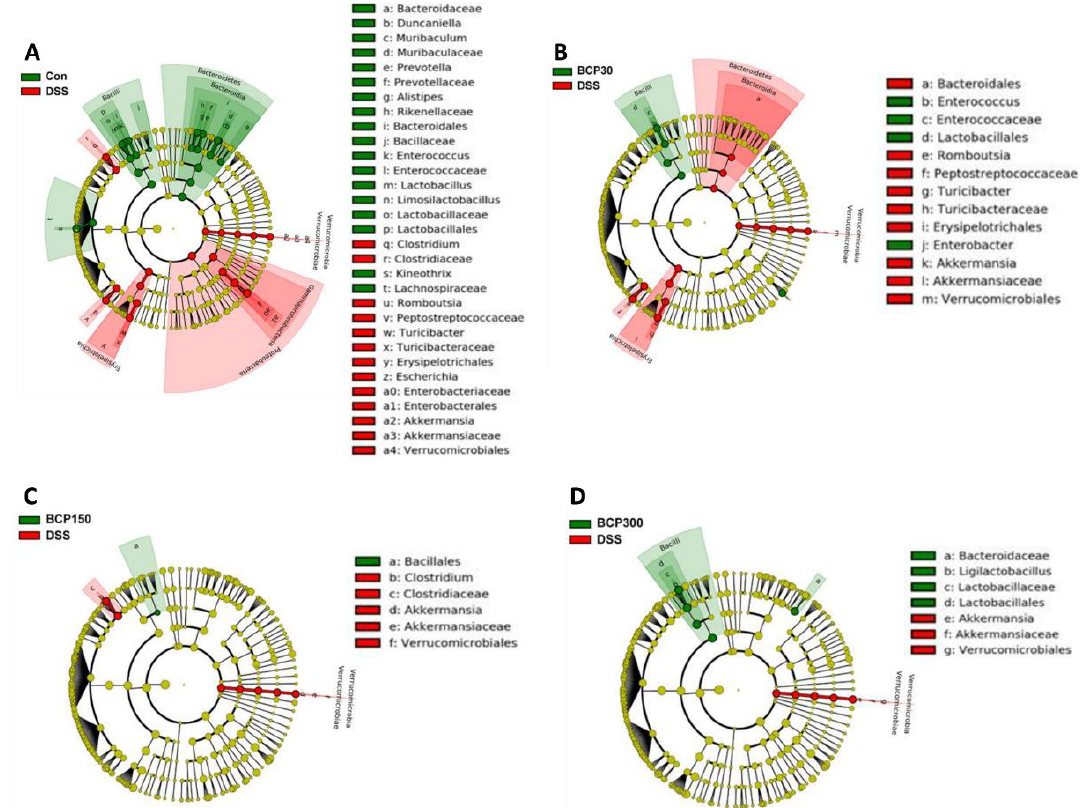
Figure 9. Linear discriminant analysis effect size of the microbiome in mouse feces of ( A ) untreated control group vs DSS-treated group and ( B ) 30, ( C ) 150 and ( D ) 300 mg/kg BCP + DSS-treated group vs DSS-treated group.